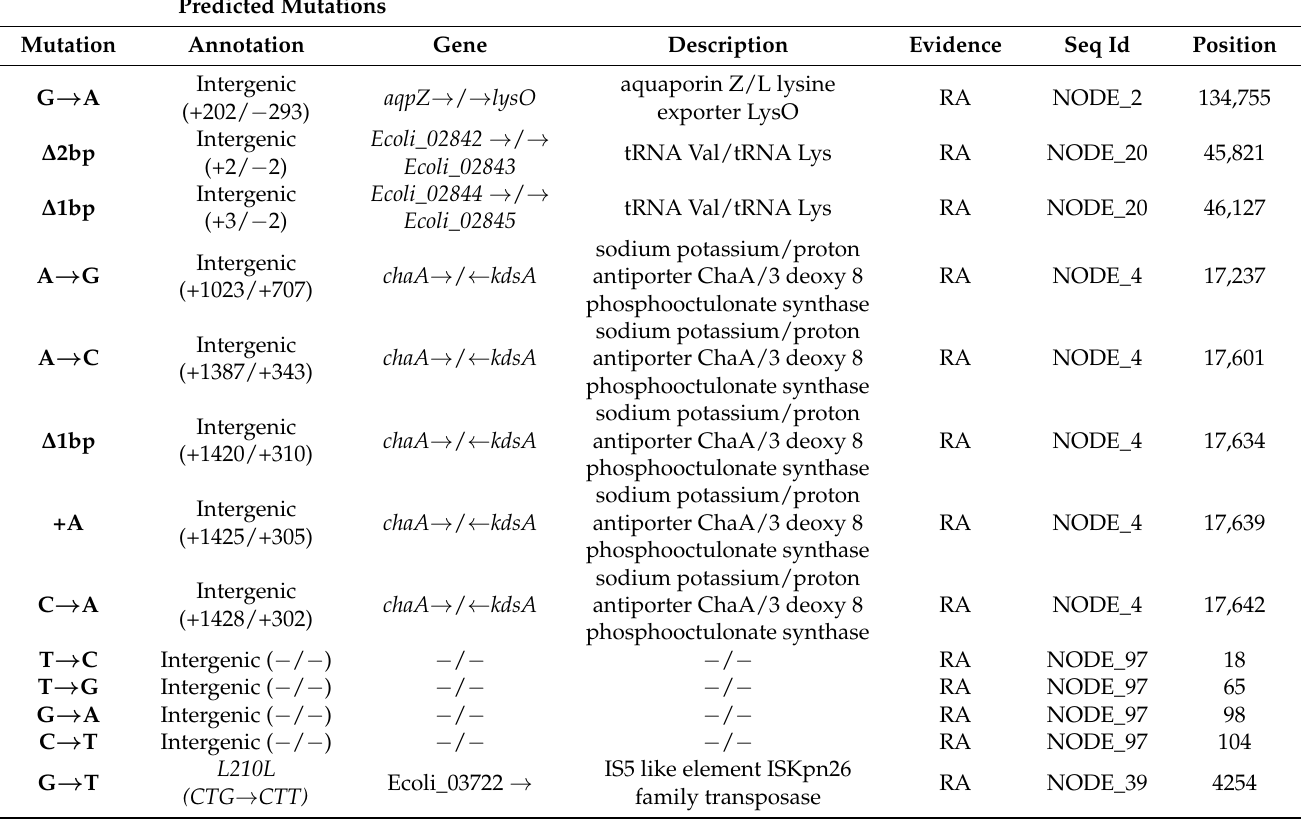
Table 2. Mutations shared between all resistant isolates. Arrows ( → ) in the first column (Mutation) indicate the nature of the mutation, for example, G → A indicates guanine is replaced by adenine. Deletions are denoted by the delta sign ( ∆ ). Addition of an amino acid is indicated by a plus sign (+). The arrows in the column Gene indicate the direction of transcription of the genes on the genome and intergenic regions are denoted by a forward slash ( → / ← ). In other words, the mutation G → A occurs in the intergenic region (/) between the genes aqpZ and lysO which are both forwardly transcribed ( → ) on the genome. Evidence from mapped reads is categorized in read alignment (RA), missing coverage (MC) and/or new junction (JC).